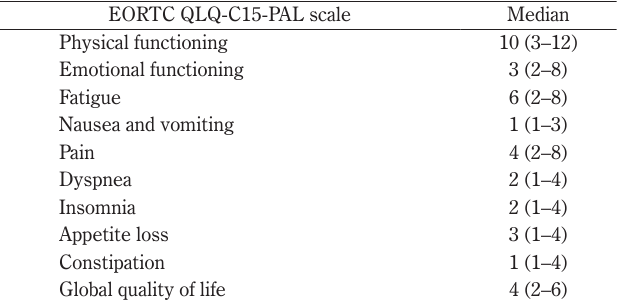
Table 2 EORTC QLQ-C15-PAL scale (n=33) EORTC QLQ-C15-PAL scale